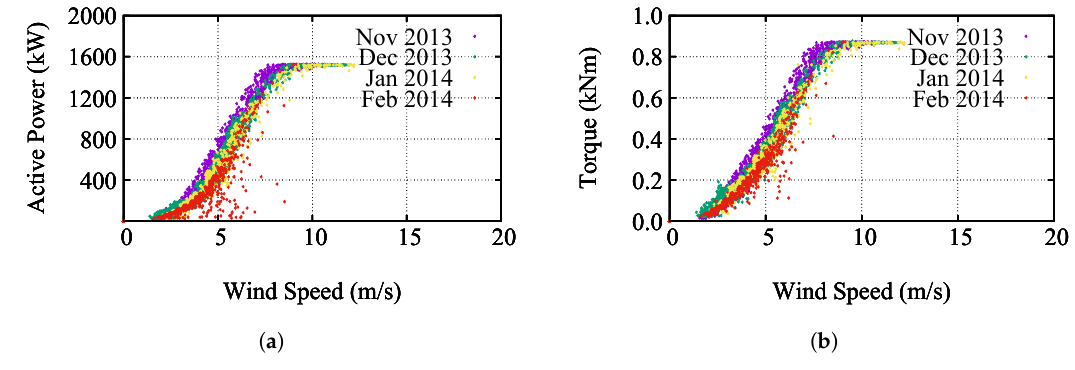
Figure 3. Active power vs. speed ( a ) and torque vs. wind speed ( b ).